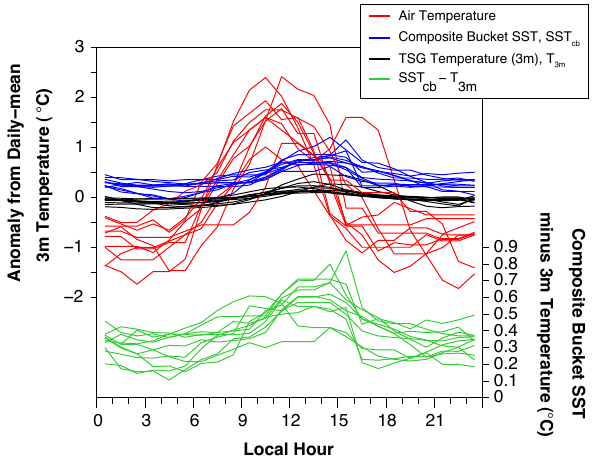
Fig. 6. Diurnal cycles within the weak, moderate and strong branches of the South Equatorial Current from three-hour moving averages. Air temperature, composite bucket SST and 3m thermos- alinograph temperature are plotted on the left-hand axis and ex- pressed as anomalies from daily mean 3m temperature for the re- spective local day. Temperature difference across the upper 3m is plotted on the right-hand